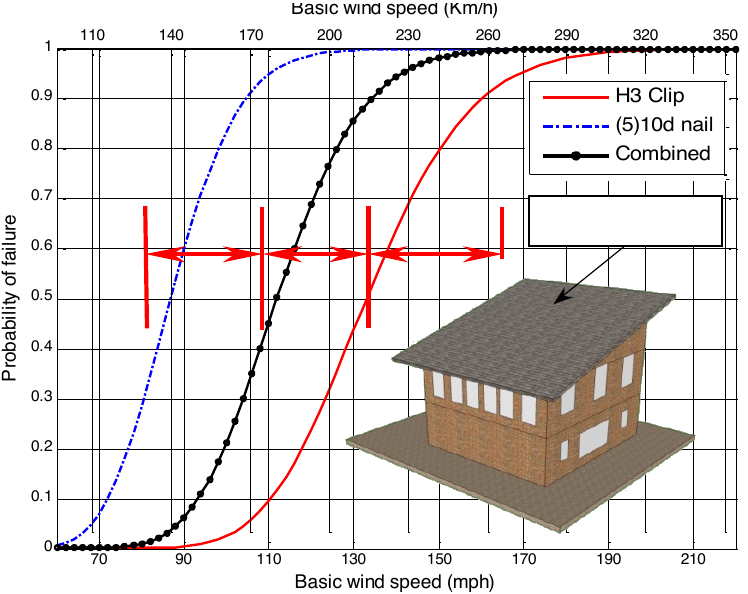
Figure 9. Fragilities for roof-to-wall